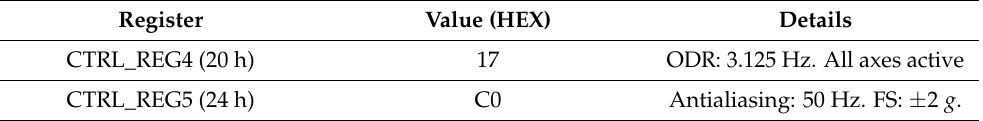
Table 4. Configuration of the studied units.